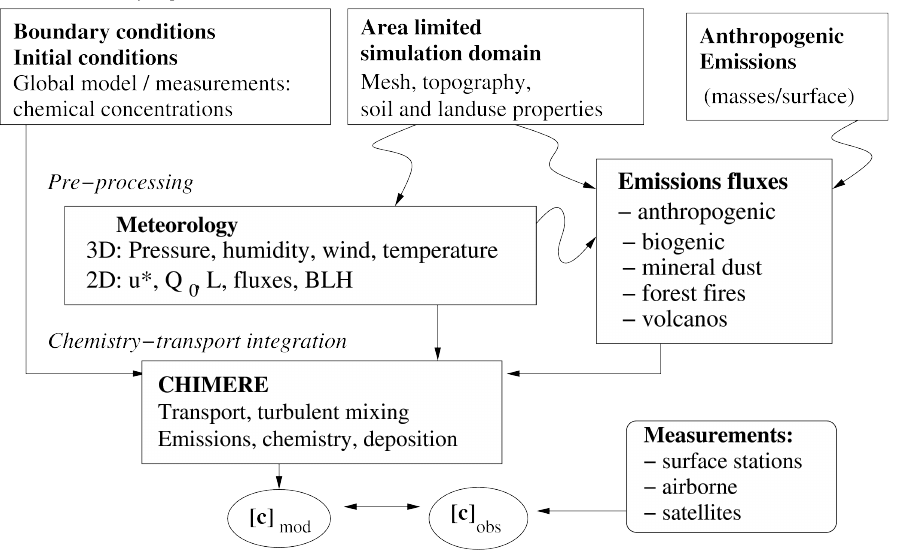
Fig. 1. General principle of a chemistry-transport model such as CHIMERE. In the box “Meteorology”, u ∗ stands for the friction velocity, Q 0 the surface sensible heat flux, L the Monin–Obukhov length and BLH the boundary layer height. c mod and c obs are the modelled and the observed chemical concentrations fields, respectively.